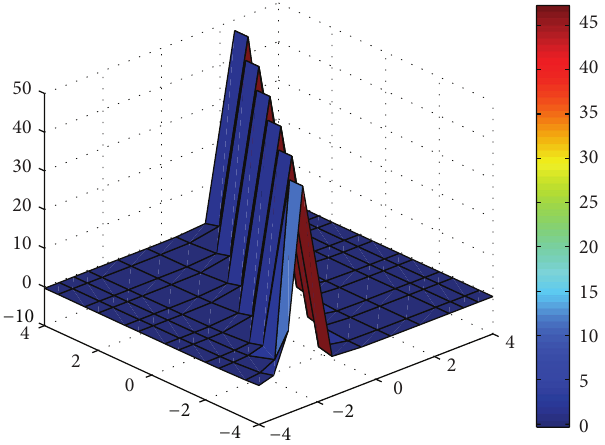
Figure5:Thesolitarywaveandbehaviorofthesolutions ℎ(𝑥,𝑦,𝑡) = −1/3+4/3 csch 2 (𝑥−2/3𝑦+𝑡) for 𝑡 = 0 , −4 ⩽ 𝑥 ⩽ 4 , and −4 ⩽ 𝑦 ⩽ 4